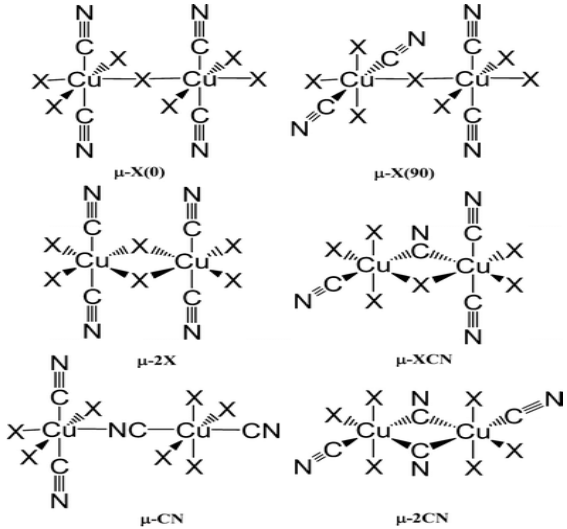
Figure 10. Isodensity of HOMO (left) and LUMO (right) for Cu(CN) 2− monomers (top), μ-Cl2 dimers (middle) and μ-ClCN dimers (bottom). (Reprinted with permission from [41]. Copyright 2012 American Chemical